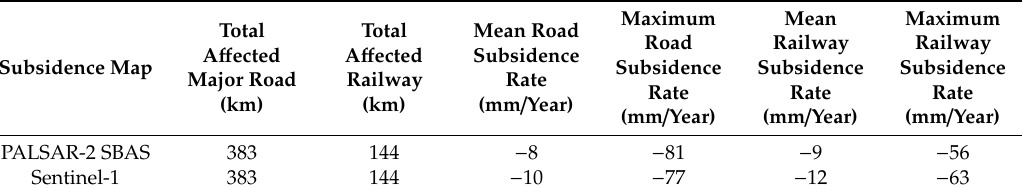
Table 2. Detailed information of a ff ected length of railways and roads in PALSAR-2 and Sentinel-1 displacement maps.